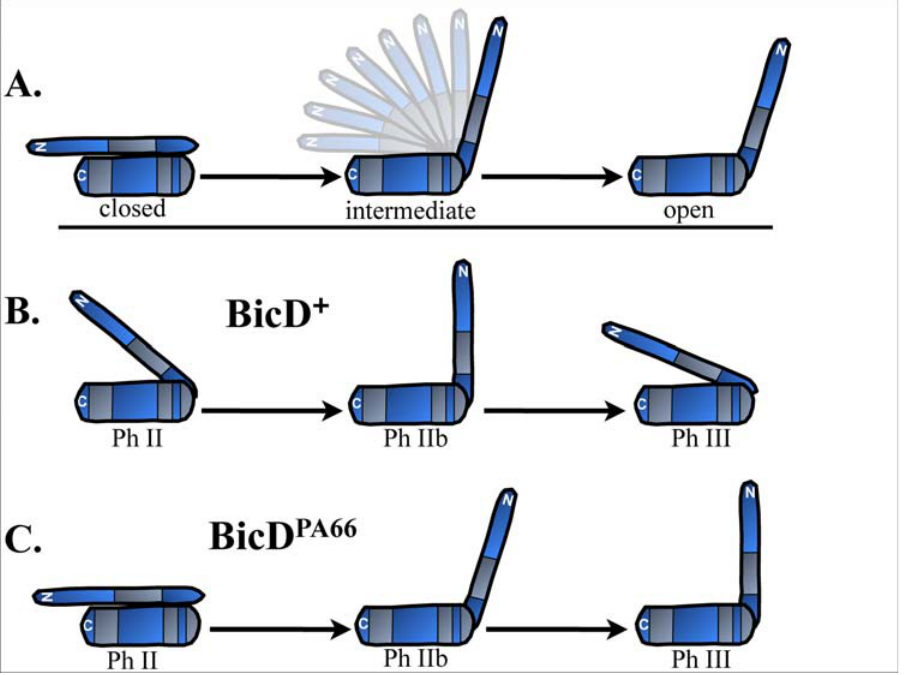
Figure 7. A proposed model for the proper regulation of BicD and the effect of the PA66 lesion. A: Past studies have indicated that BicD has a flexible linker region between its two globular domains (Stuurman et al. , 1999) and that an intramolecular interaction of the N- and C-terminal domains might represent a closed/inactive state (A, left) that can open to interact (A, right) with other regulatory components (Hoogenraad et al. , 2001). B: Wild-type BicD may regulate its active state by either controlling how frequently it alternates between a completely open/active vs. a completely closed/inactive state or through an ability to take an intermediate conformation. Therefore, intermediate conformations shown for wild- type (B left, B right) are simply intended to suggest that BicD molecules are not locked in one state or the other. Yet, the open stature of BicD shown for phase IIb of wild-type (B, middle) is intended to suggest a relatively open/active state. C: The A40V lesion of BicD PA66 could affect N- to C-terminal interaction within BicD. BicD PA66 tracking results could suggest that there is an abrupt change from a closed to an open state sometime near phase IIb, followed by a clear inability down-regulate the open/active state once it has occurred, as seen in phase III (C).